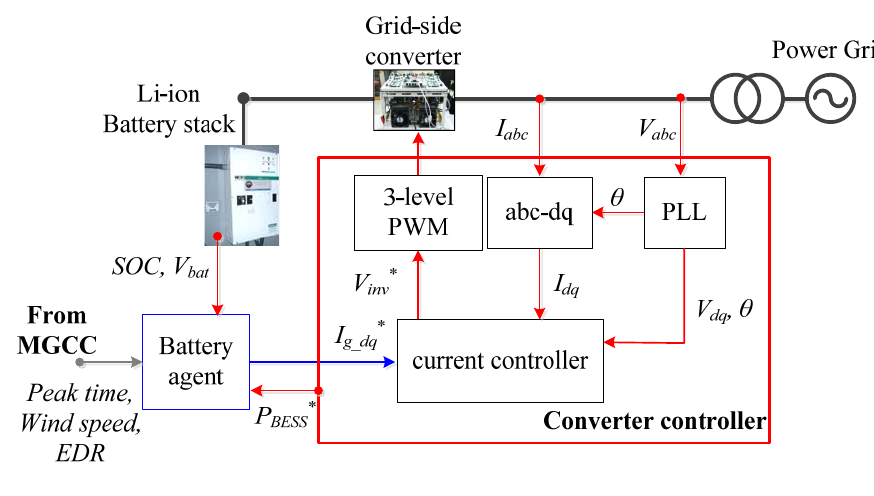
Figure 3. Configuration of BESS and control block